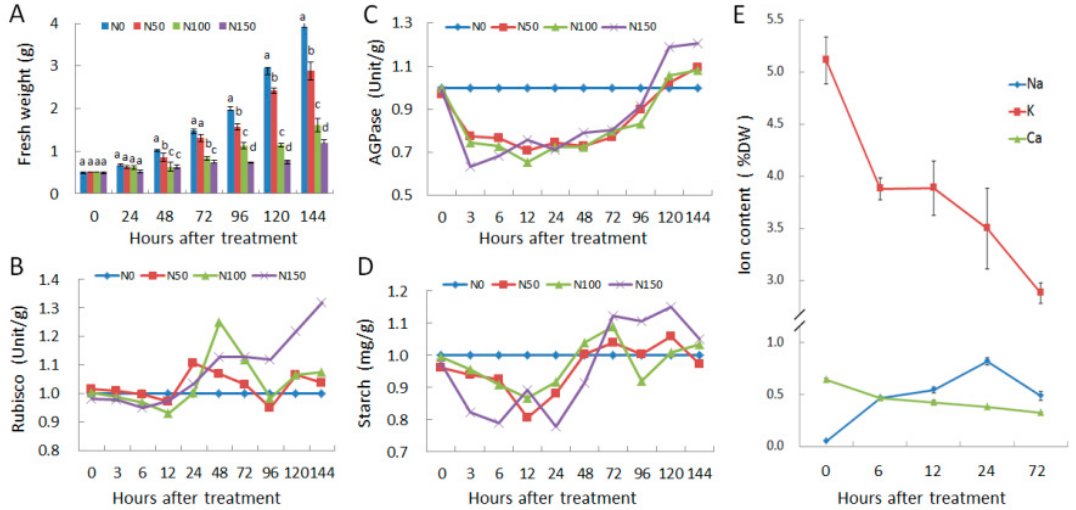
Figure 1. Physiological responses of duckweed ( Spirodela polyrhiza ) in response to salt treatments. Fresh weight ( A ), relative Rubisco enzyme activity ( B ), relative AGPase activity ( C ), relative starch content ( D ) and Ion content ( E ) were investigated under four salt concentrations of 0, 50, 100, and 150 mM NaCl (designated as N0, N50, N100, and N150, respectively) across ten time-points (0, 3, 6, 12, 24, 48, 72, 96, 120, and 144 h) within six days. Sodium, potassium, and cassium contents were measured at 0, 6, 12, 24, and 72 h and presented in percent dry weight (%DW). The relative enzyme activities and starch content are normalized to the levels of 0 mM NaCl treatment (controls) at each time-point, so that the controls are shown as a constant 1, and the treatments (50, 100, 150 mM NaCl) are shown as relative levels to the controls. Di ff erent letters on columns in Figure 1A indicate significant di ff erence as tested using one-way ANOVA at 5% significance level.